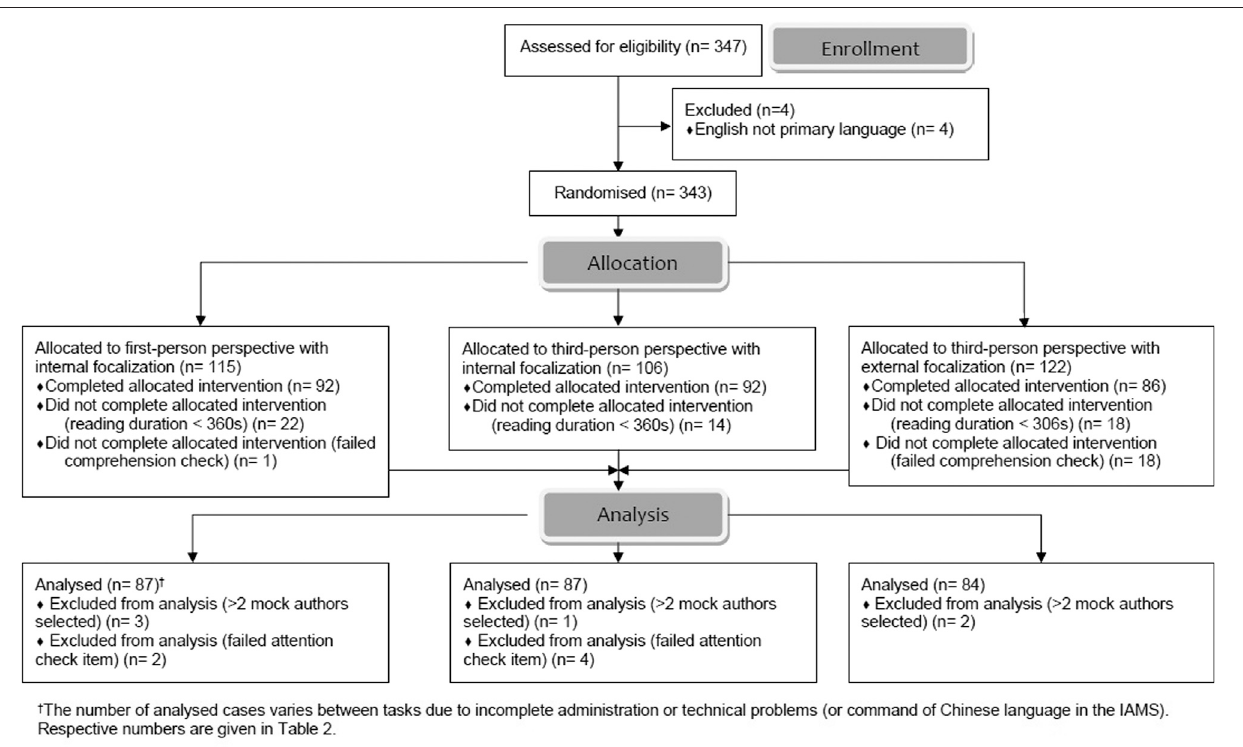
FIGURE 2 | Flow of participants through Experiment